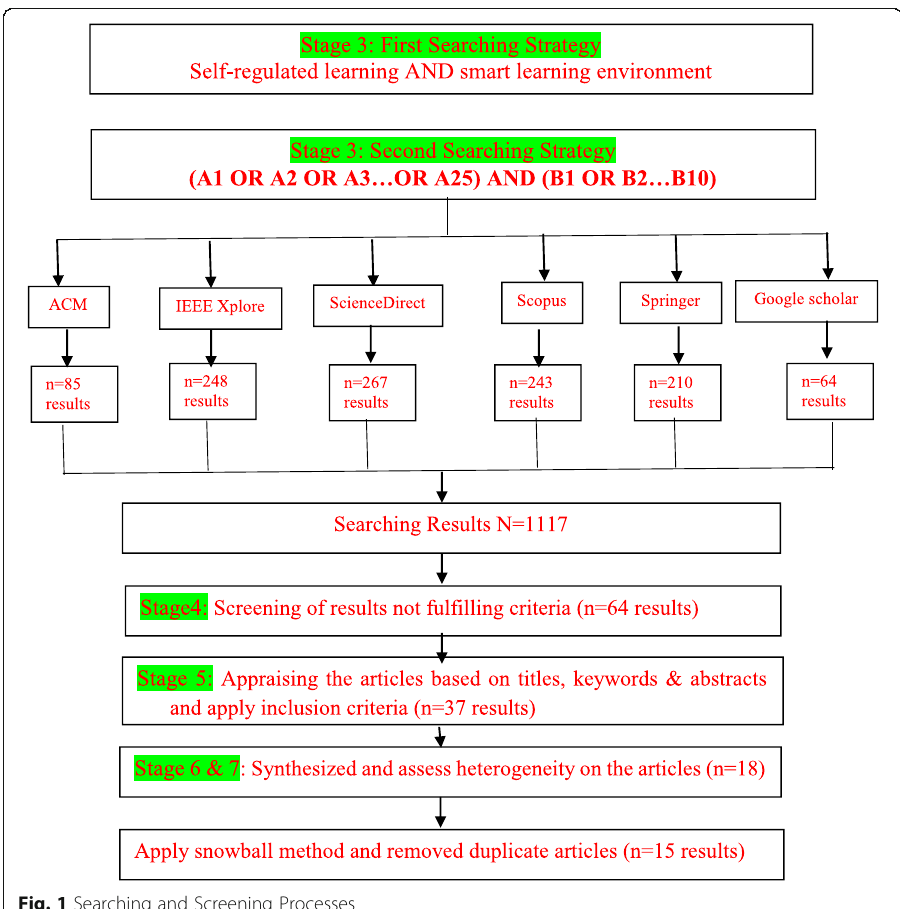
Fig. 1 Searching and Screening